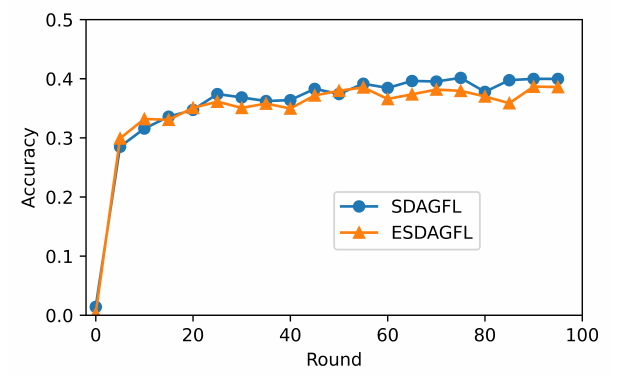
Figure 5. The average training accuracy of ESDAGFL and SDAGFL evaluated on the Poets